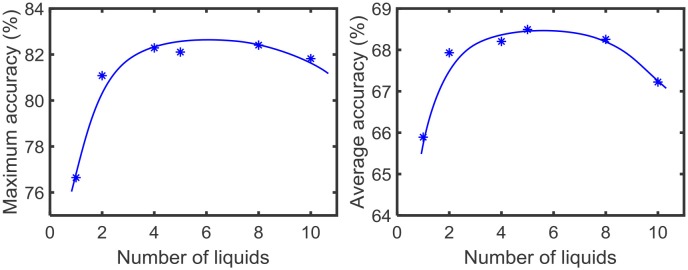
(A) The maximum accuracy among all the LSM configurations with different PIN→E and PE→E
(B) The average accuracy across all the LSM configurations with different PIN→E and PE→E.